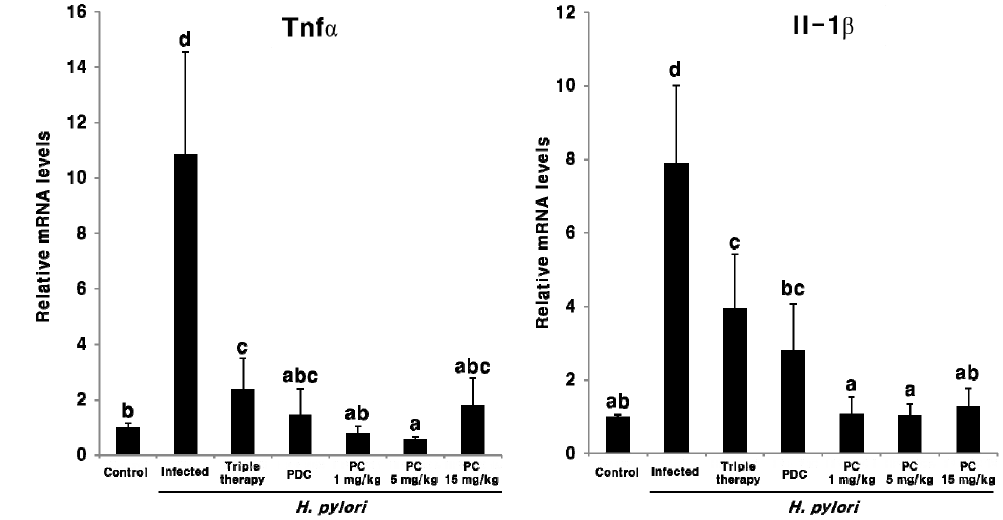
Figure 6. Effect of PC treatment on the expression of Tnf α and Il-1 β mRNA in the gastric tissue of the H. pylori -infected mice. Different letters (a, b, c, and d) indicate a significant difference ( p < 0.05), ascertained via the Tukey–Kramer test. PC, 3-pentylcatechol; PDC, 3-pentadecylcatechol.